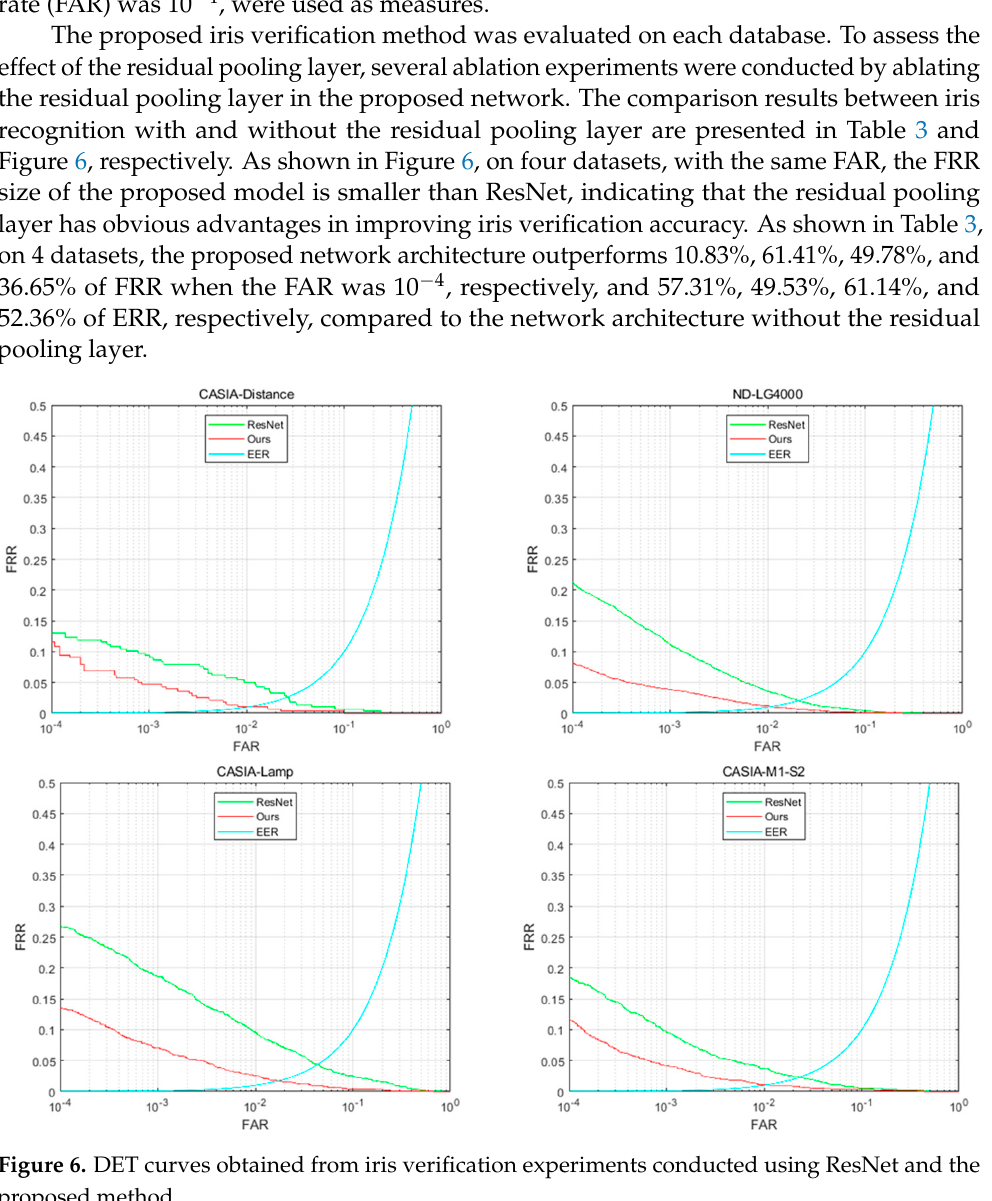
Table 3. Performance of the proposed network and ResNet.